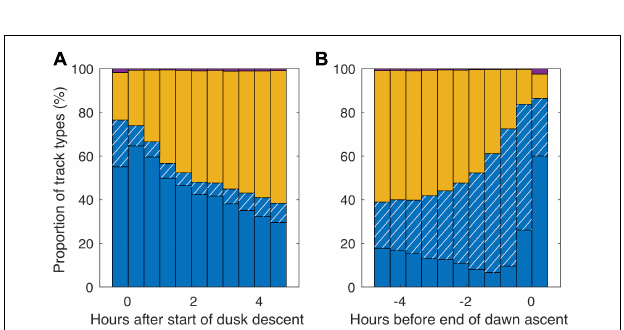
FIGURE 7 | Proportion of different swimming patterns in relation to the start of the dusk descent (beginning of midnight sinking; A ) and the end of the dawn ascent (end of midnight sinking; B ). Blue (descending) and blue hatched (ascending) bars indicate staircasing behavior, yellow bars stationary swimming and purple bars direct ascent/descent